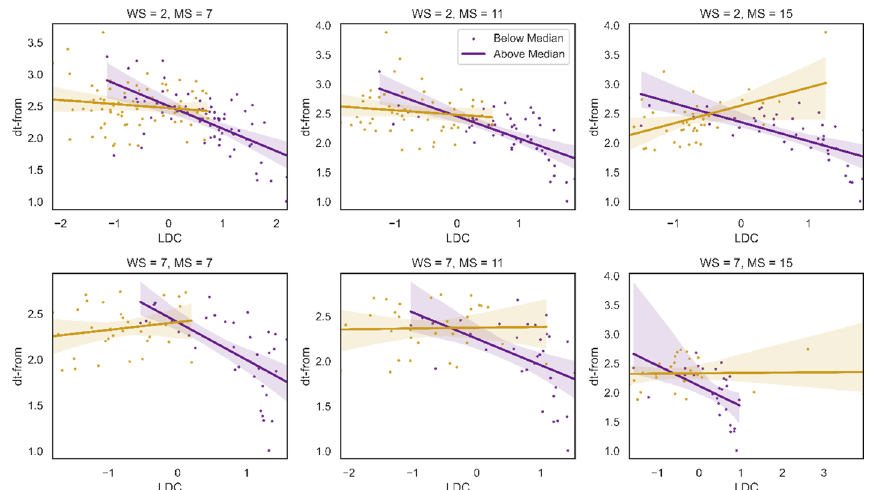
Fig. 14 Examples of interactions between LDC and average location on dt-from for WS: 2,7 and MS: 7,11,15. The x-axis denotes LDC and the y-axis denotes